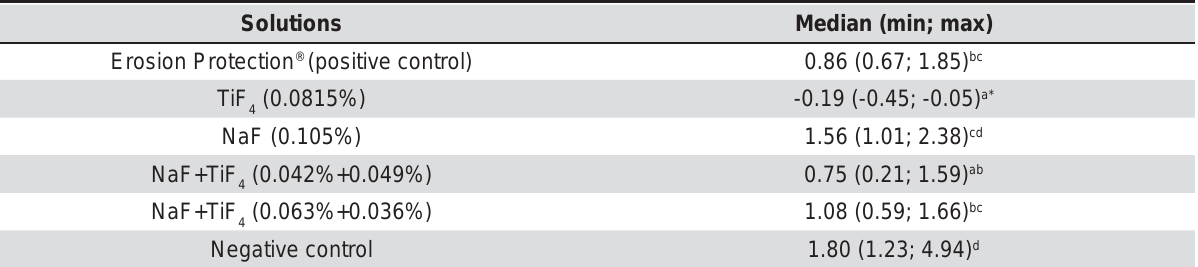
CASTILHO ARF, SALOMÃO PMA, BUZALAF MAR, MAGALHÃES Table 1- Median (minimum-maximum) of the dentin erosive loss for different groups